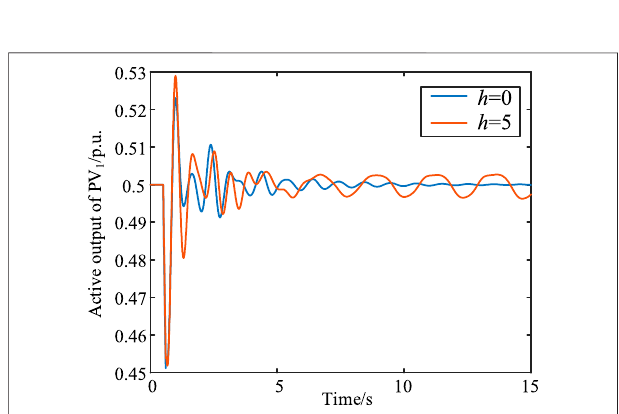
FIGURE 12 | Non-linear simulation results of the active power output of PV 1 when Z 3